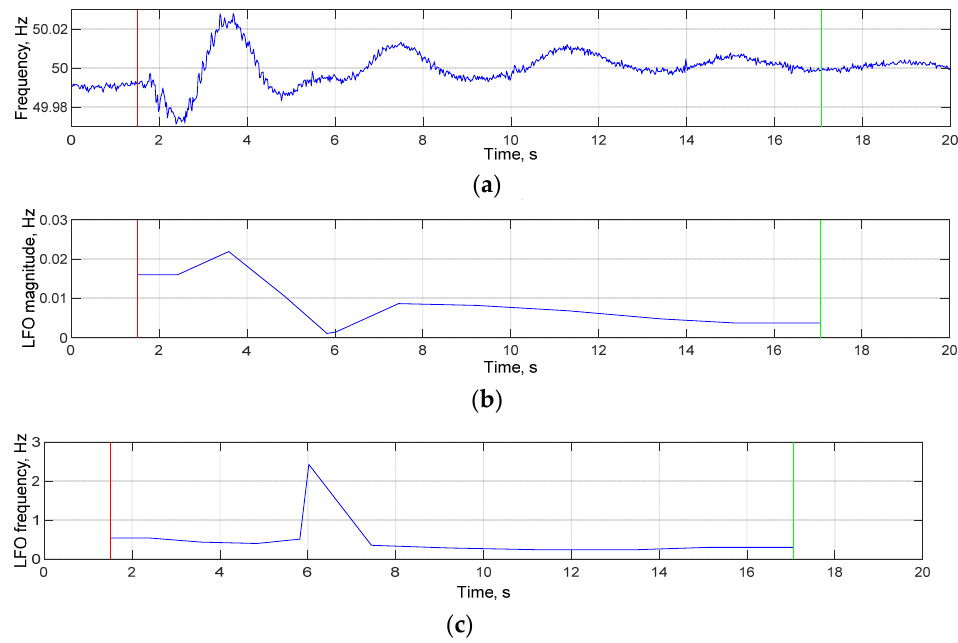
Figure 5. The initial data and, estimated amplitude and frequency of the LFO, duration of the LFO: ( a ) initial signal; ( b ) LFO frequency; ( c ) LFO magnitude.